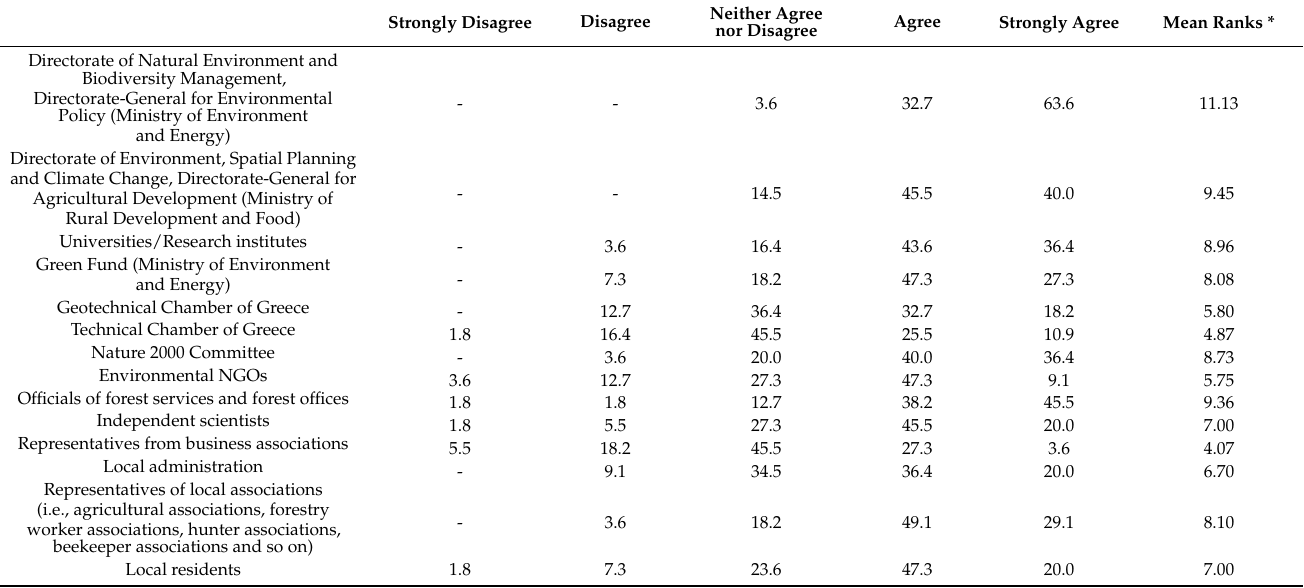
Table 5. Percentage units and differences among respondents’ views on the bodies that should participate in the